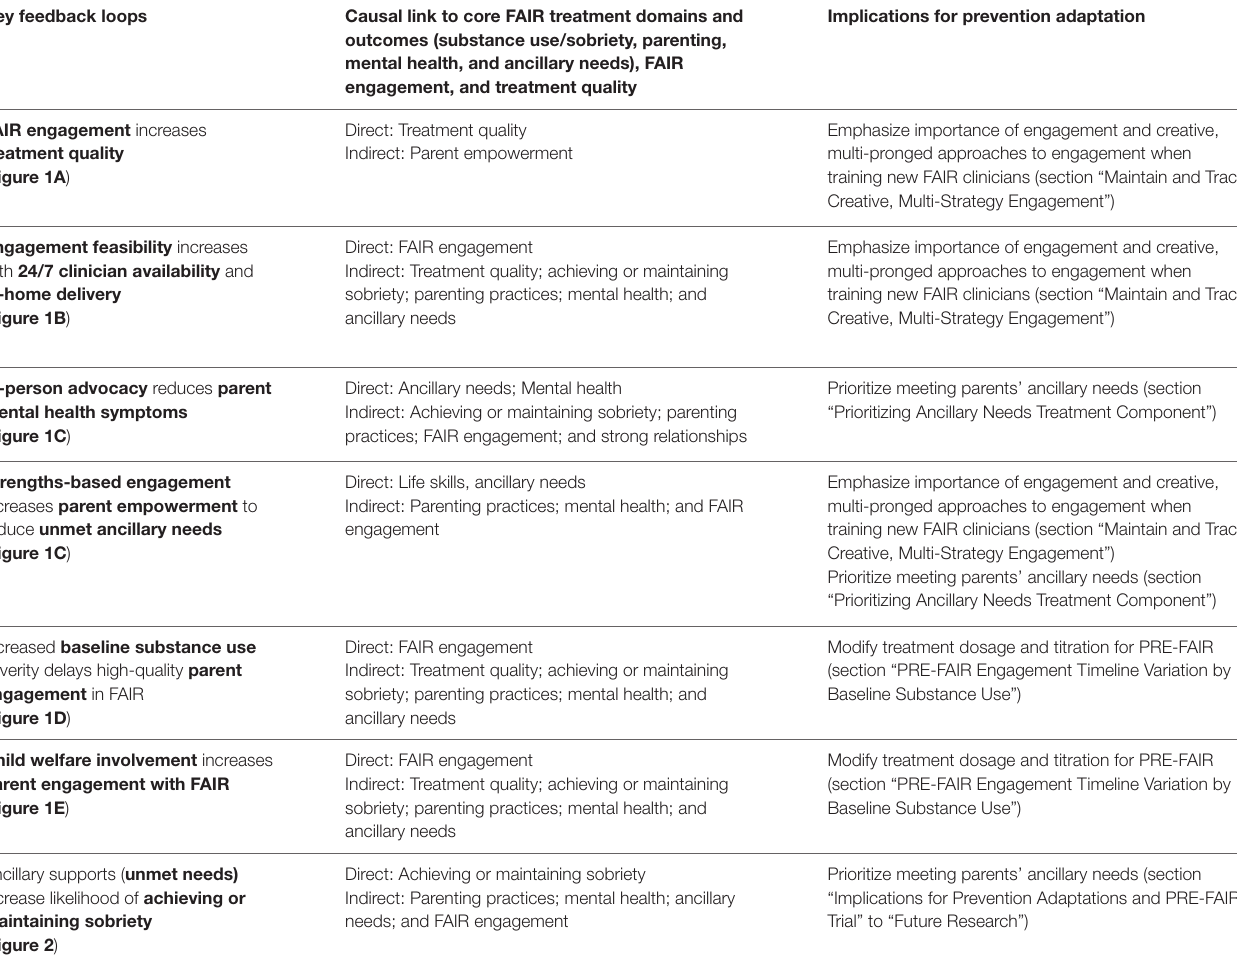
TABLE 1 | Key feedback loops for parental engagement in FAIR: Implications for prevention adaptation to PRE-FAIR. Key feedback